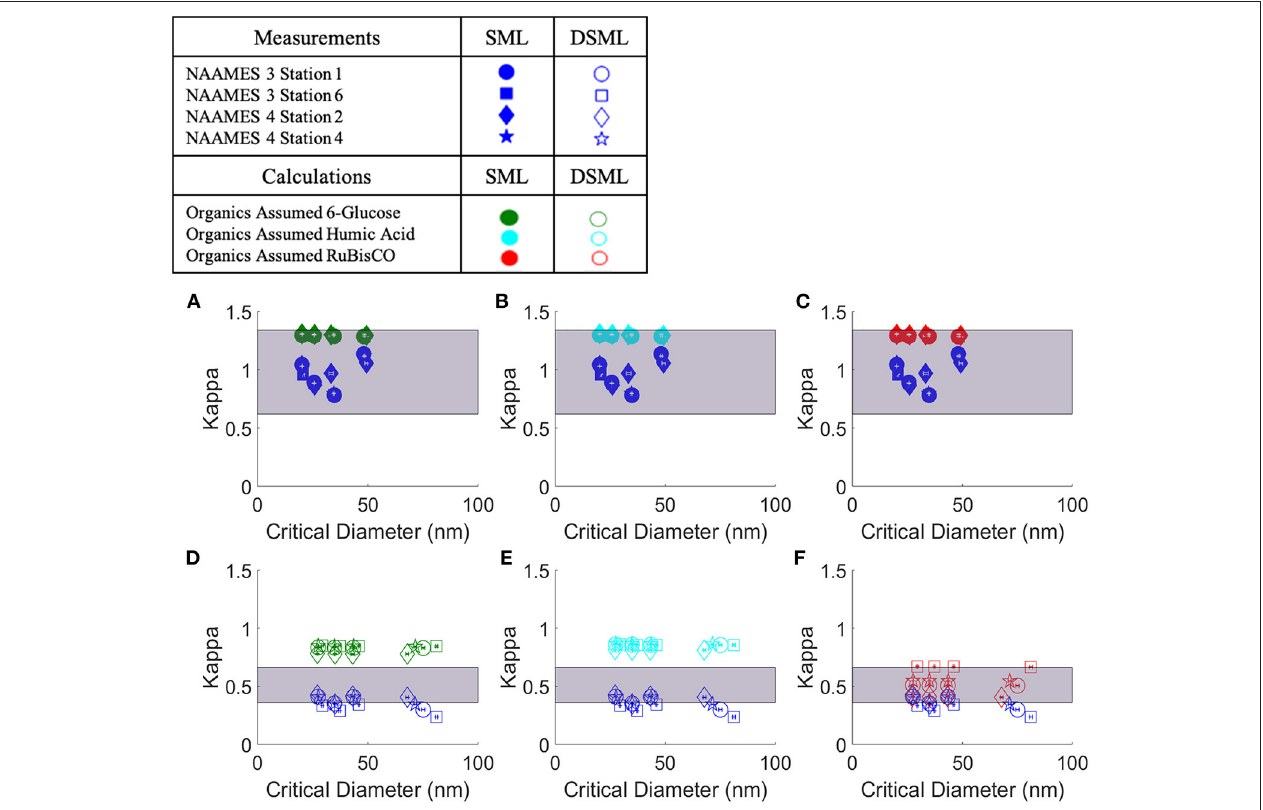
FIGURE 7 | Measured and predicted κ values for SML and DSML samples using IC data for composition of salts. The different symbols represent the SML and DSML samples collected at different stations. The dark blue symbols indicate the κ values calculated from direct CCN measurements. κ values predicted by assuming a single organic composition of 6-glucose, humic acid, and RuBisCO are presented in green, light blue, and red symbols, respectively. (A–C) show the predicted κ values and the κ values from CCN measurements for the SML samples. The predicted κ values are also provided in Table 4 . The white lines on each symbol show the error associated with that measurement which was determined using error propagation analysis. The gray box presents the uncertainty in the κ value for seawater salts, represented by NaCl (upper boundary, 1.34) and calcium sulfate (lower boundary, 0.62), both of which are components in seawater. (D–F) show the predicted κ values and the κ values from CCN measurements for the DSML samples. These κ values include the small amount of salt remaining after dialysis. Error bars were calculated using error propagation analysis. The purple box indicates a range of κ values calculated for the organics assuming the organic molecular weight, density, and number of carbons may independently vary by + 50% relative to RuBisCO, as described in Table 5 (Cases 2–7).